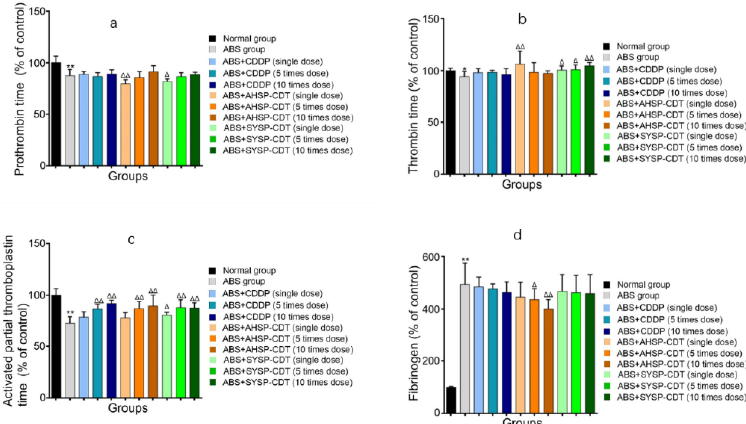
Figure 13. Bar chart of Danshen preparations’ effect on the prothrombin time (PT) ( a ), thrombin time (TT) ( b ), activated partial thromboplastin time (APTT) ( c ), and fibrinogen (FIB) ( d ) of acute blood stasis rats. Compared with the normal group, * p < 0.05, ** p < 0.01; Compared with the ABS group, Δ p < 0.05, ΔΔ p < 0.01.